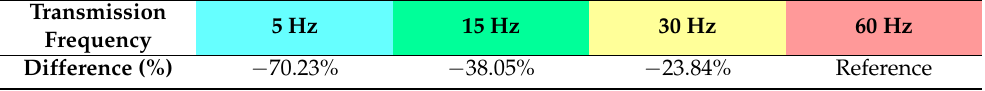
Table 4. Differences in the radio band occupancy depending on the frame transmission frequency.